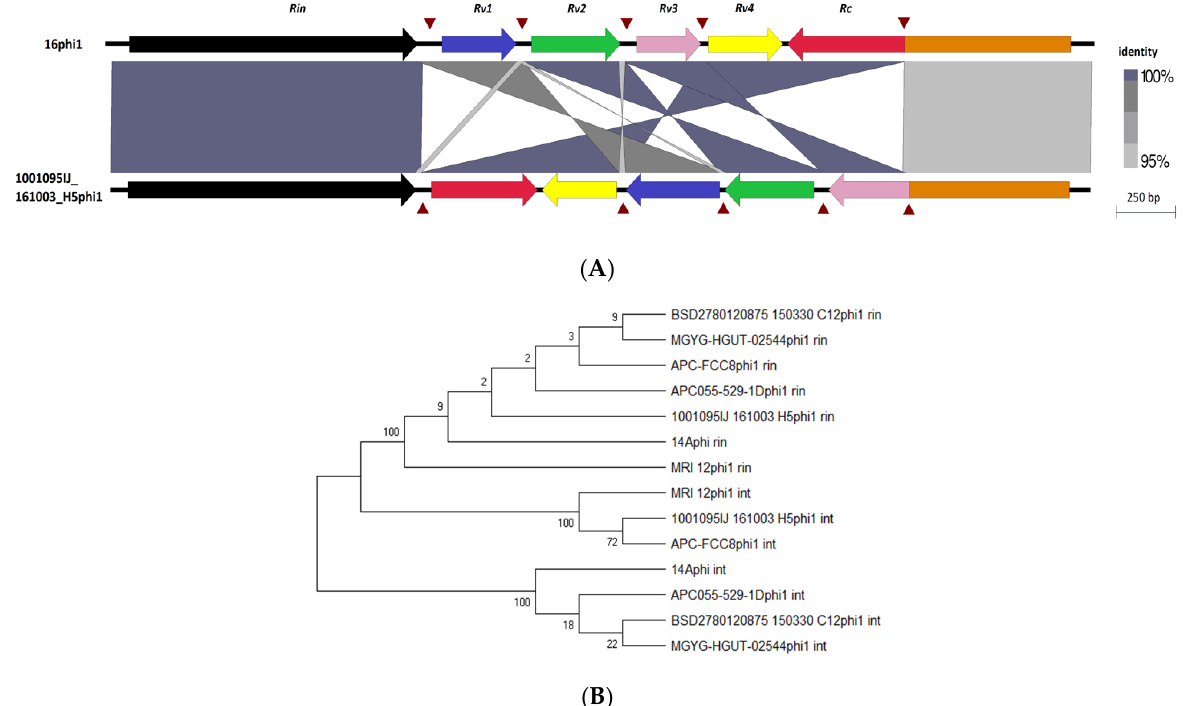
Figure 5. Characterisation of Rin shufflon among E. lenta prophages. ( A ) Locus map showing the alignment of the Rin shufflon among prophages 16 phi1 and 1001095IJ_161003_H5phi1, genes (arrows) relative to the direction of transcription and labelled accordingly to function. Brown triangles indicate repeat regions and shaded regions represent the degree of sequence homology in BLASTn alignments. ( B ) Unrooted maximum likelihood tree of invertases and intergrases among E. lenta clade 1 prophages.